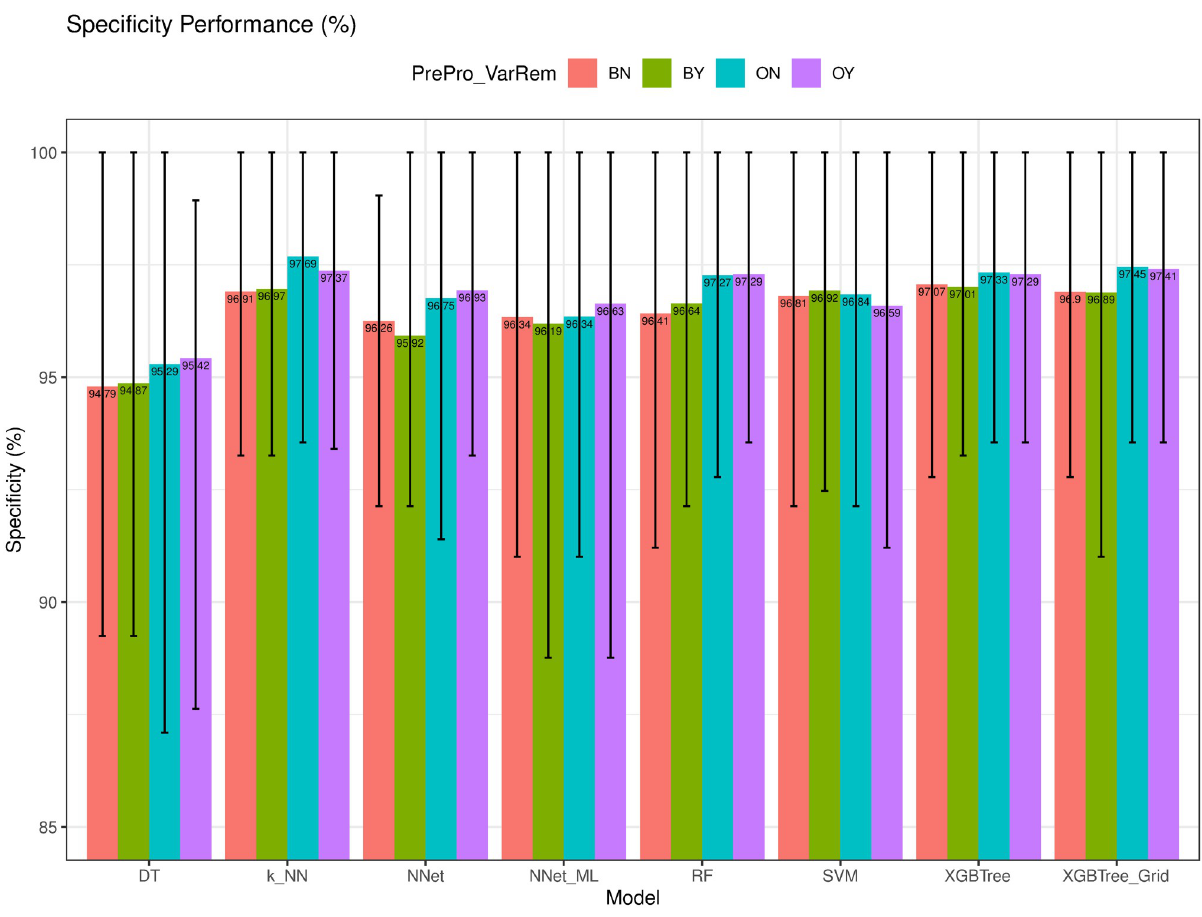
Fig 11. Specificity ( Spe ) of different